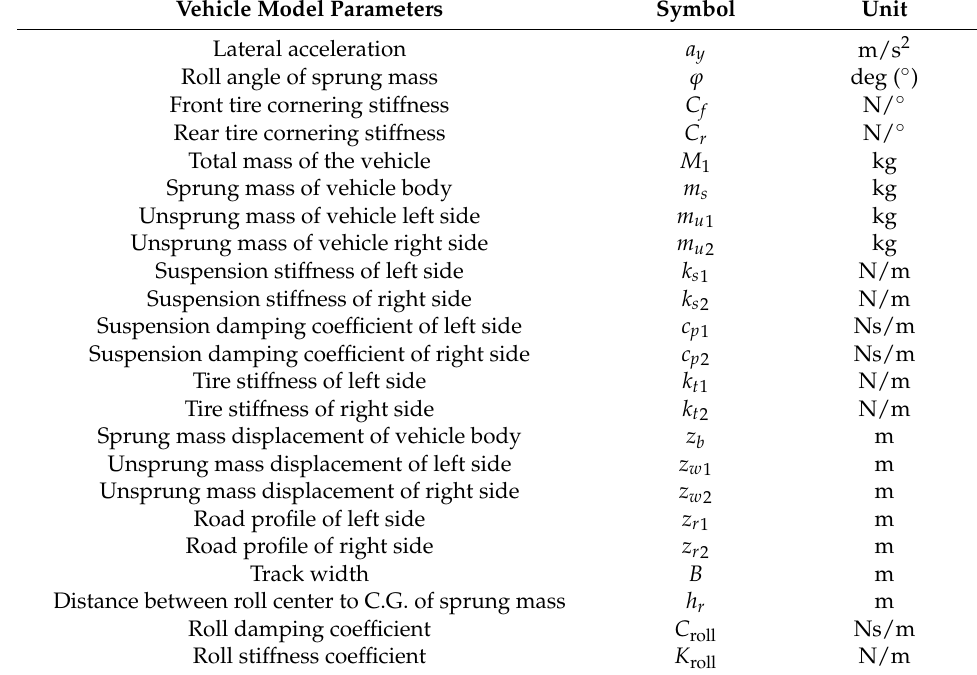
Table 2. Description of symbols for 6-DOF half-car dynamics